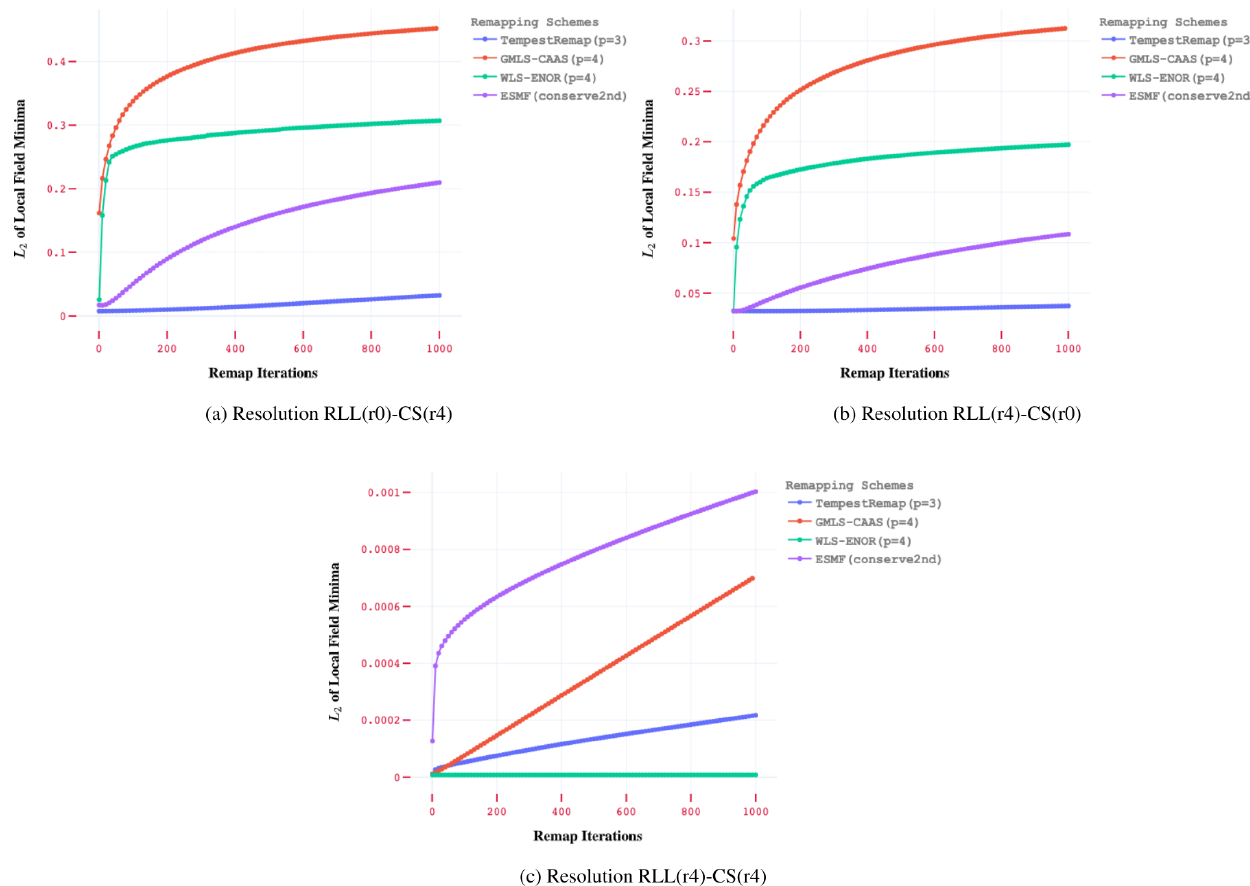
Figure 11. L min , 2 metric for the TOPO field on RLL-CS meshes with different resolutions.